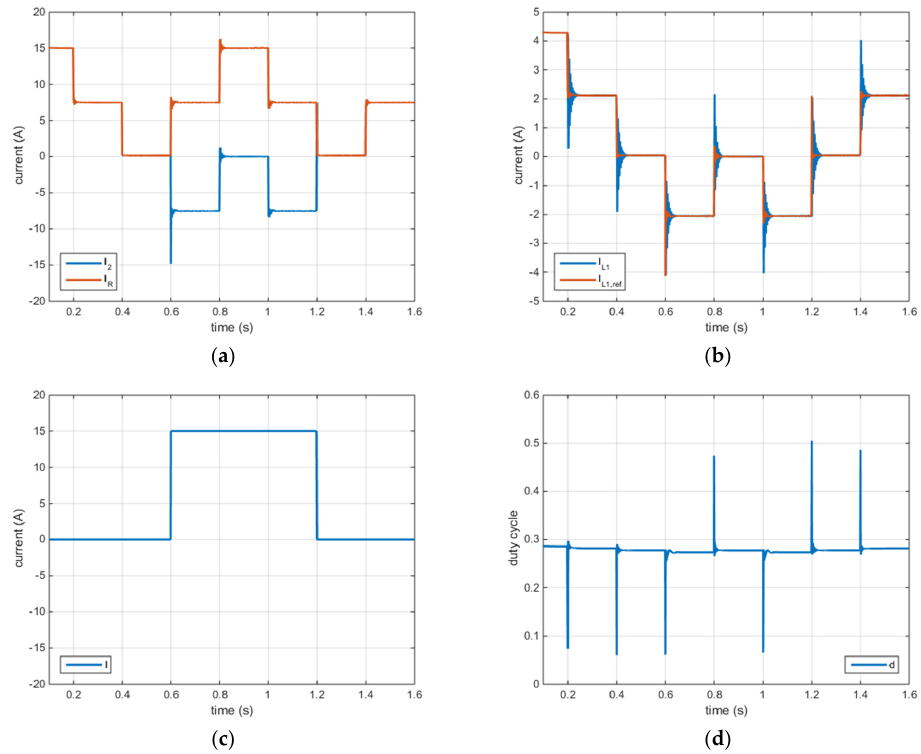
Figure 6. Simulation results in scenario #1 (SS − GN): ( a ) output and load currents; ( b ) input inductor current and its reference; ( c ) external generator’s current; ( d ) duty cycle.